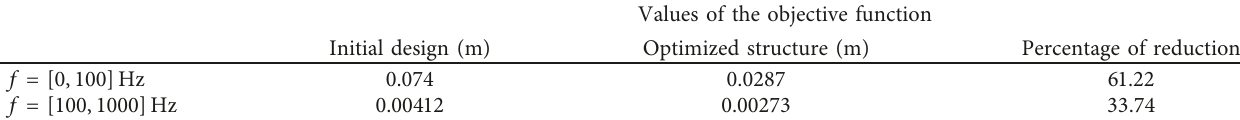
Figure 4: The convergence histories of the objective function. (a) f Table 1: The comparison of the values of the objective function before and after optimization.